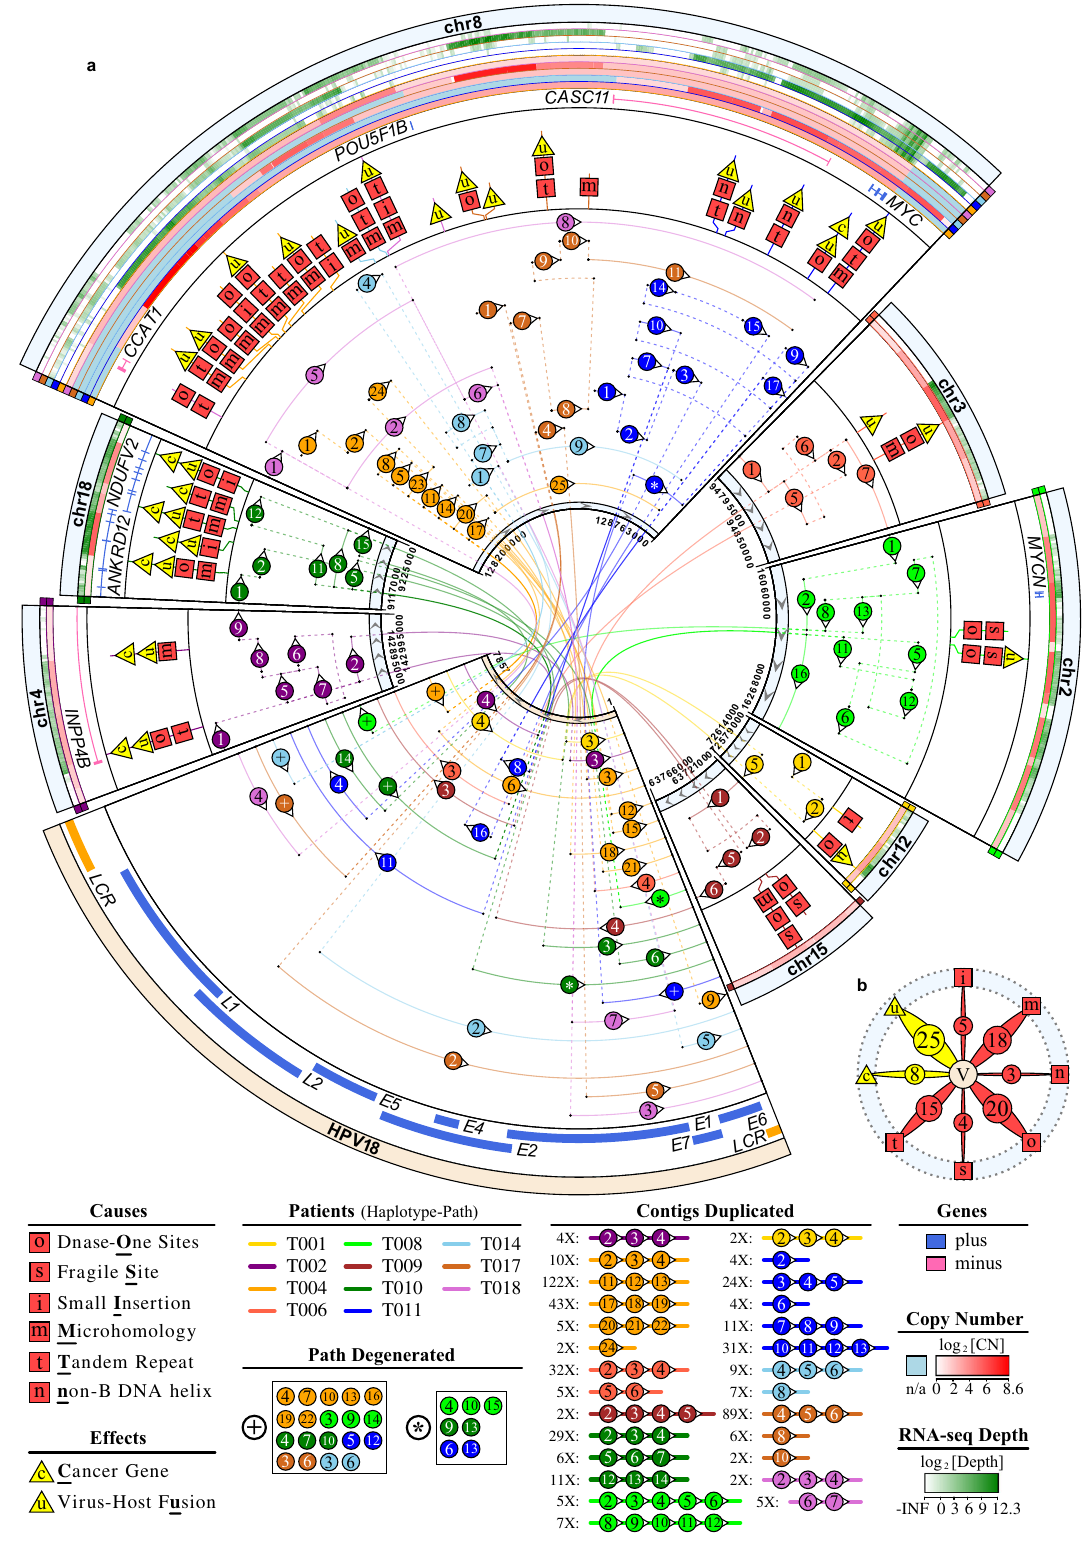
Fig. 3 | Features of HPV18-integrated local haplotype. a Human genomic seg- mentsrelatedtoHPV18-integratedlocalhaplotypesareshownassectorswiththeir relevant haplotype path in sample-speci fi c colors. Regions of local haplotypes are notedbycirclednumbersinsequence,wheresomearedegeneratedbysymbolsfor simpli fi cation. Repeat times of contigs in local haplotypes are stated in the fi gure legend. Features of HPV18-integrated sites are depicted as single-letter icons. DNA